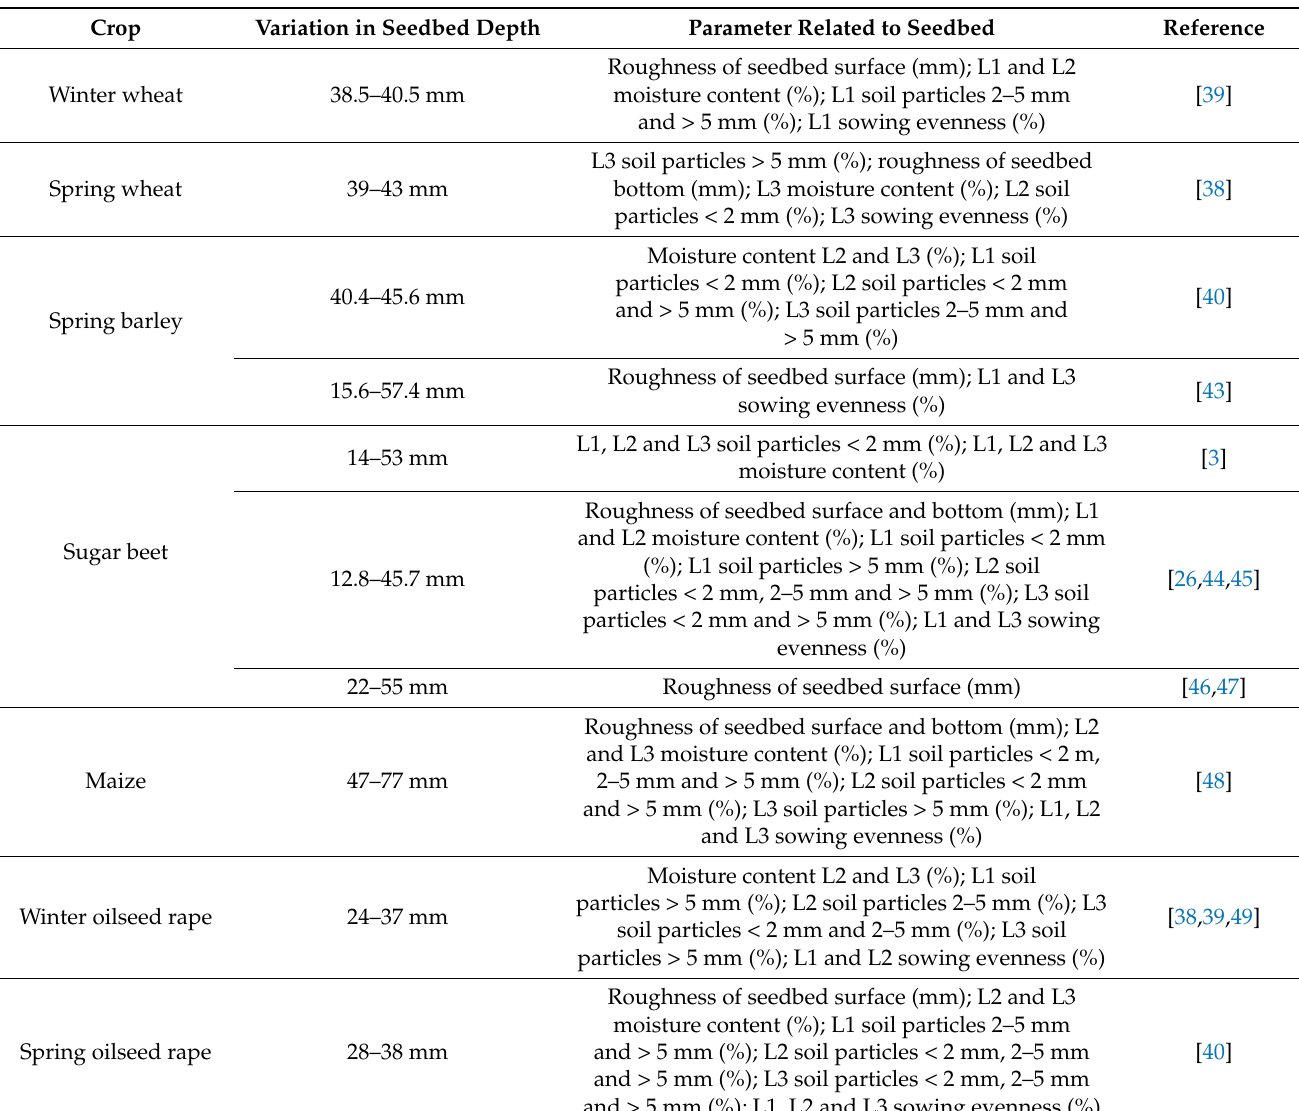
Table 1. The relation of seedbed depth to other seedbed